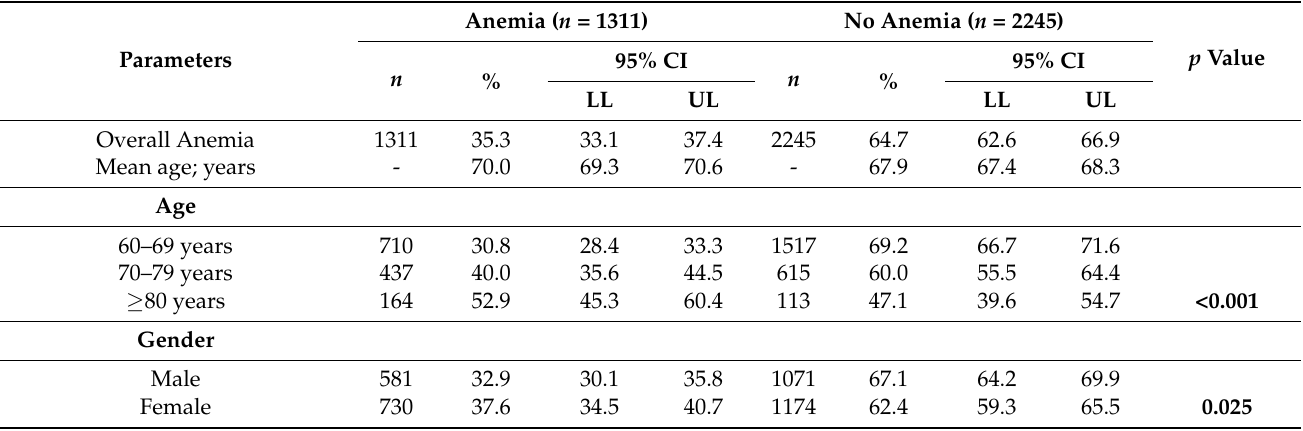
Table 2. Prevalence of anemia among older persons according to chronic disease and disability factors: NHMS